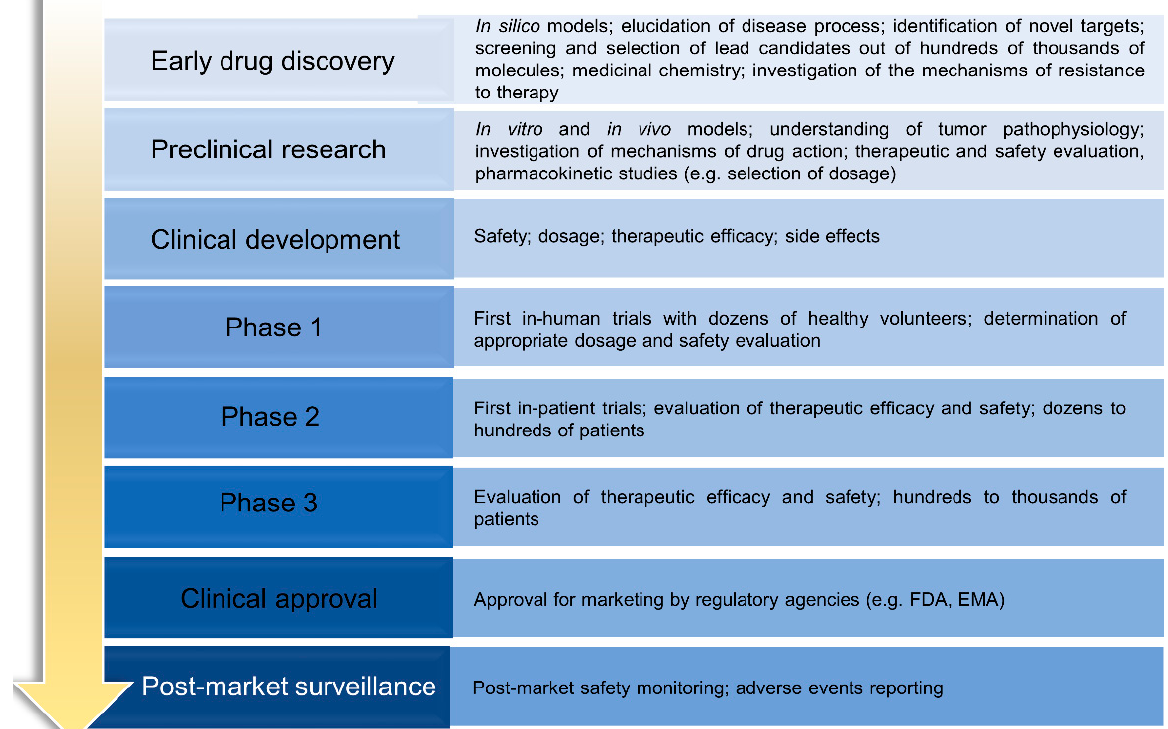
Figure 2. Drug development steps, from early drug discovery to post-market surveillance.